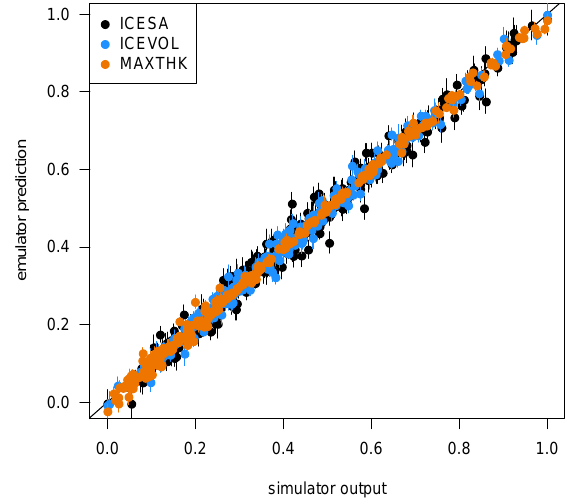
Fig. 3. Leave-one-out cross-validation for a Gaussian process emulator, showing good performance in prediction. We exclude a member from the ensemble, and predict the output, given the set of input parameters. We repeat this process across the ensemble, for three summary simulator outputs. Vertical lines represent ± 1 standard deviation.